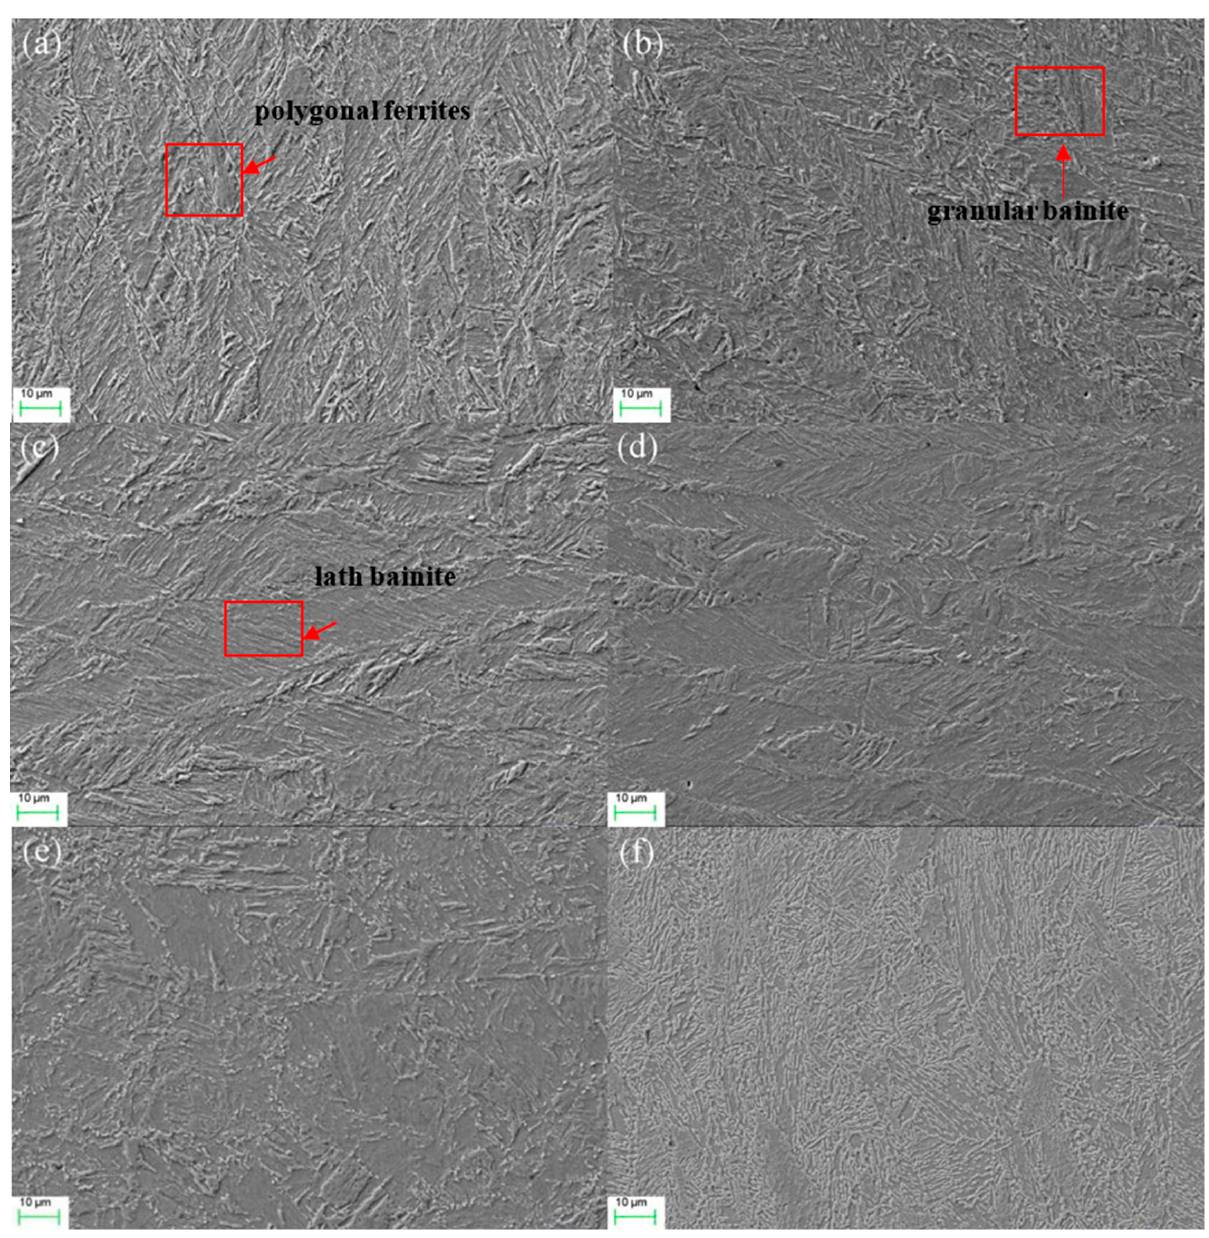
Figure 3. SEM images of N1 steel tempered at: ( a ) 450 °C; ( b ) 500 °C; ( c ) 550 °C; ( d ) 600 °C; ( e ) 650 °C; ( f ) 700 °C.